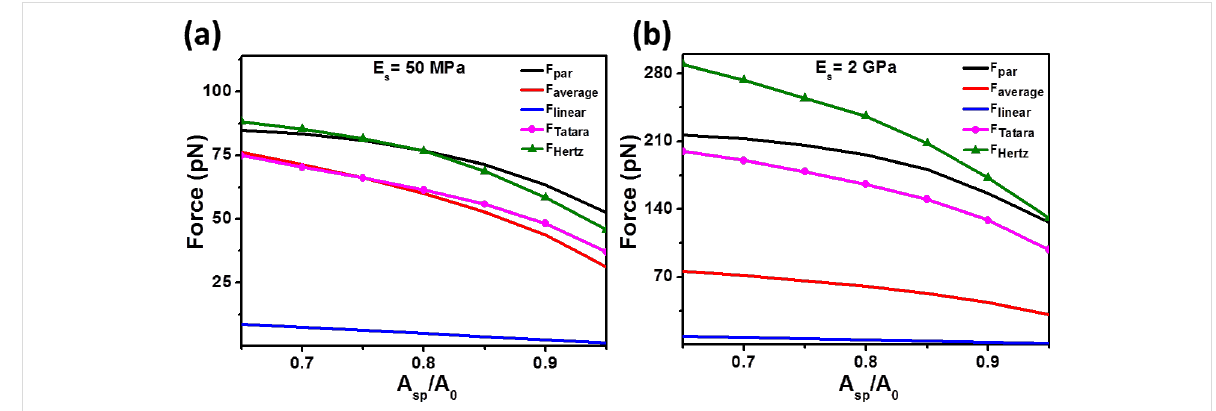
Figure 3: Dependence of the peak force on the set-point amplitude for different numerical simulations (Hertz and Tatara) and force analytical approxi- mations (parametrized, average and linear). (a) A 0 = 1 nm and E s = 50 MPa. (b) A 0 = 1 nm and E s = 2 GPa. Simulation inputs are: k = 0.1 N/m, f 0 = 25 kHz, Q = 2, R t = 5 nm, and R s = 4 nm.